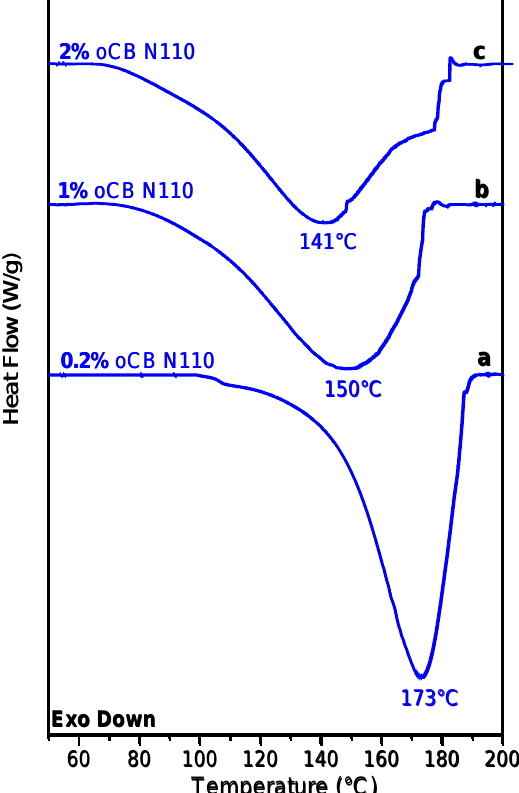
Figure 5. DSC scans at a heating rate of 10 °C/min for resorcinol/HMMM resins (for the weight ratio 1) and different amounts of oCB-N110: ( a ) 0.2 wt %; ( b ) 1.0 wt %; and ( c ) 2.0 wt %. Exothermic peak positions ( T peak ) and peak shifts (Δ T = T peak (unfilled) − T peak (filled)), as